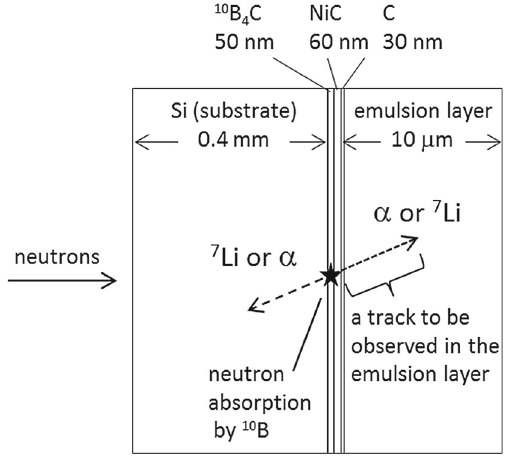
Fig. 1 Aschematicviewofthedetector.Whenaneutronisabsorbedin the 10 B 4 C layer, two ions, an α -particle and a 7 Li nucleus, are emitted. One of them is detected as a track which is several microns long in the emulsion layer